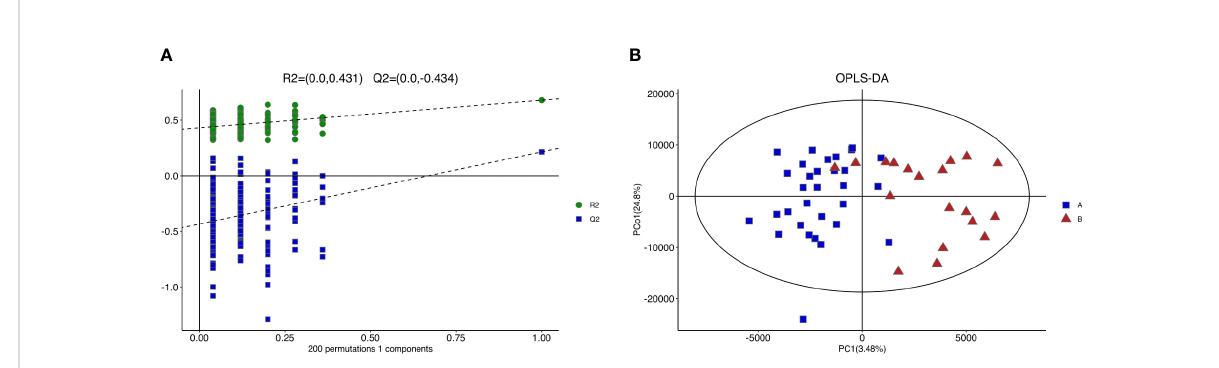
FIGURE 5 Results of replacement test and OPLS-DA score of girls with CPP vs the control group. (A) The closer R2Y was to 1, the more stable and effective the model was. Q2<0 indicated that the model was reliable and effective without over- fi tting. (B) There was signi fi cant difference in OPLS-DA score between the two groups.